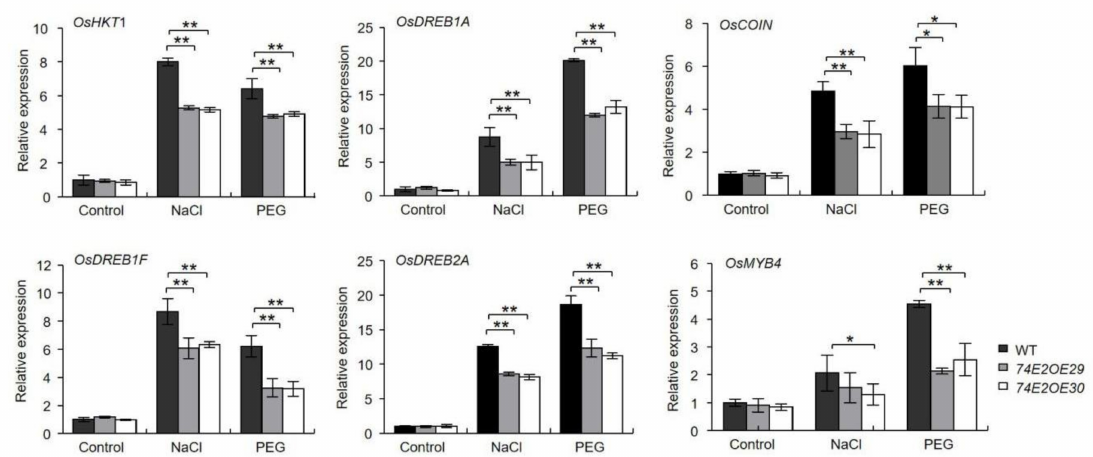
Figure 8. Expression of stress-responsive genes is downregulated upon UGT74E2 overexpression under abiotic stress. For RNA extraction, seven-day-old rice plants were subjected to 200 mM NaCl and 15% PEG (polyethylene glycol) treatment for 12 h. Gene expression was normalized to the reference gene OsActin . For each experiment, three replicates were done; data are presented as means ± SD. Student’s t -test for each genotype was performed (* p < 0.05, ** p <